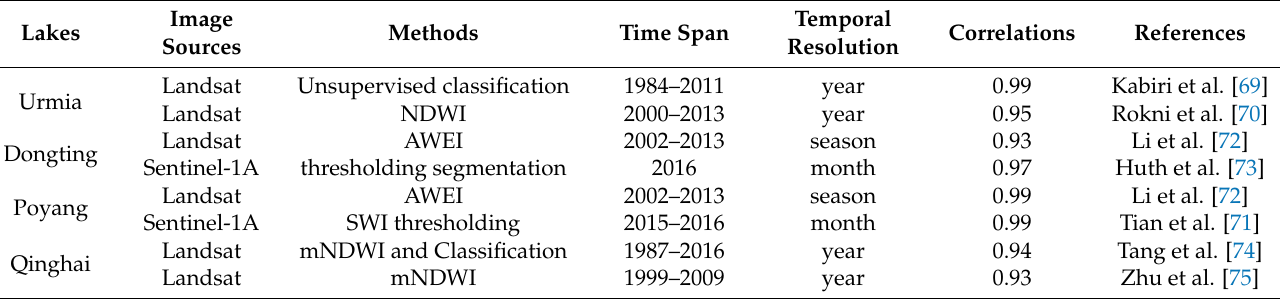
Table 5. Summary of studies by other researchers for case